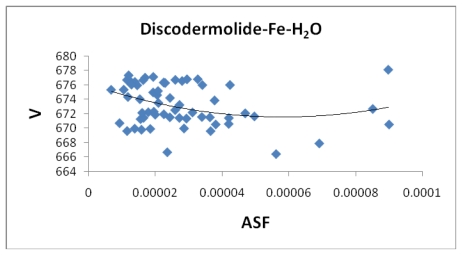
The volume (Å3) plotted against the aqueous stability factor (Jm/D) for the Fe-Dis-H2O complex. The best fit equation was determined to be y = 1*109x2 − 154248x + 676.07 (R2 = 0.0943).